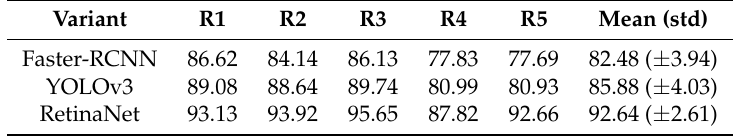
Table 2. Average precision (%) for cumbaru tree detection in five cross validation rounds (R1–R5).